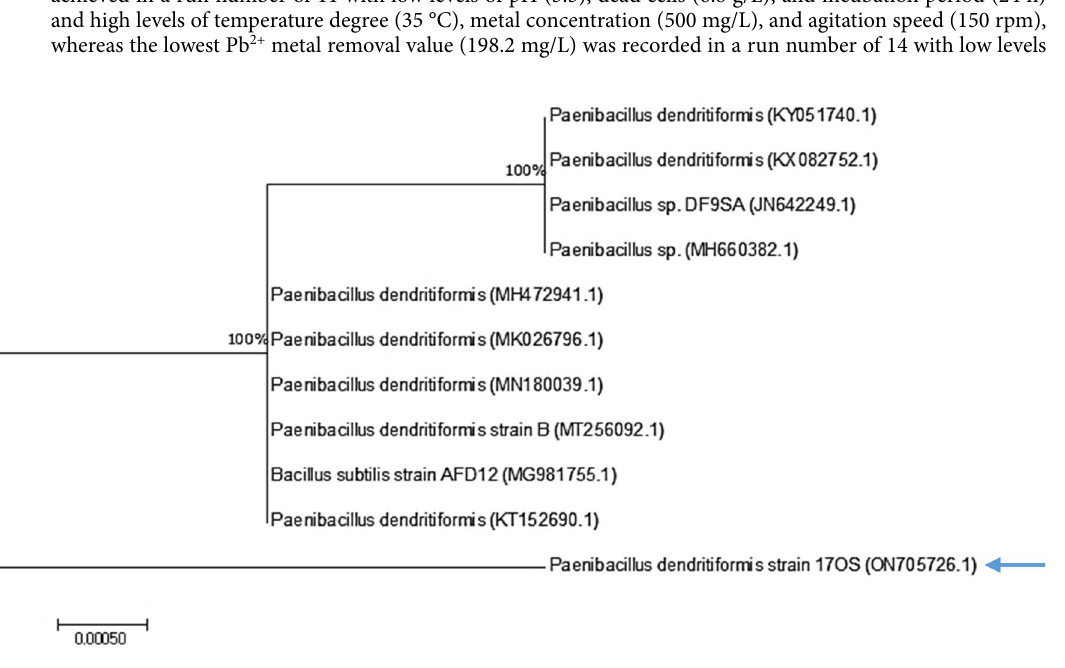
Figure 4. Phylogenetic tree constructed using 16S rDNA sequences of 17OS isolate using the neighbor-joining method (Evolutionary analyses were conducted using